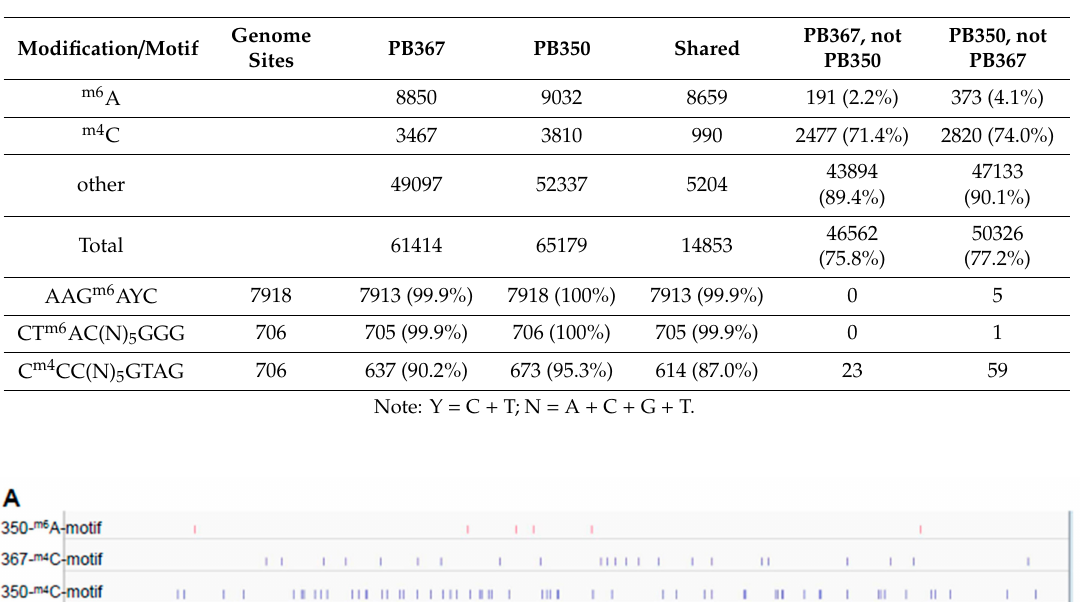
Table 2. Genomic modifications and methylation motif sequences in two P. aeruginosa isogenic isolates from the same patient.